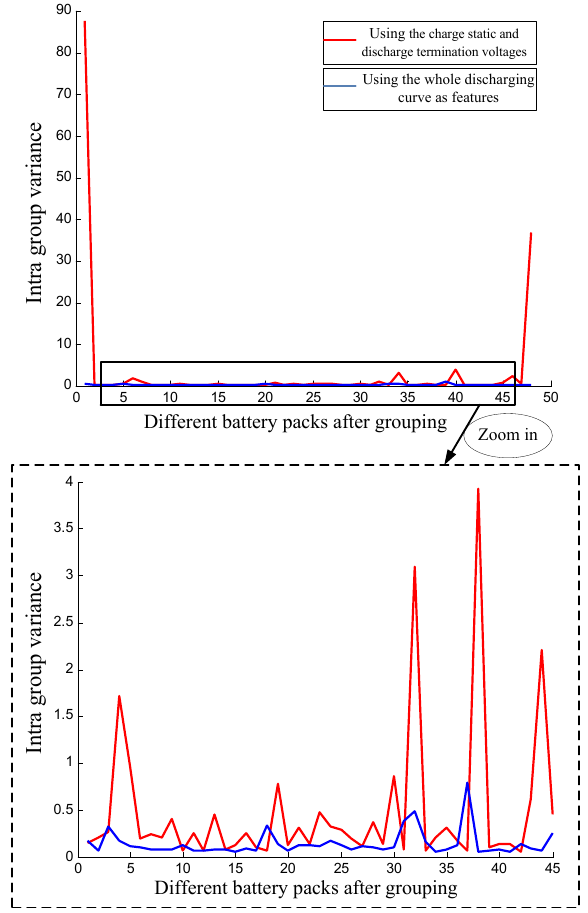
Figure 9. The comparison of intra group variances: Results only using the charge static voltage and discharge termination voltage and results using the whole discharging curves. Note that the proposed method using the whole discharging curves can achieve smaller variances and better intra group